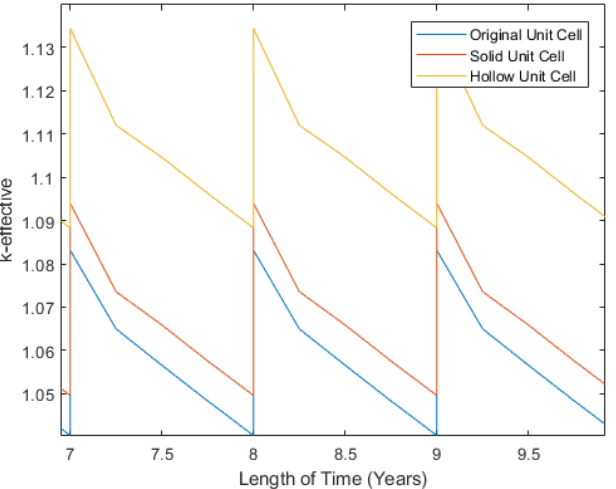
Figure 3: Criticality of core through cycle for each unit